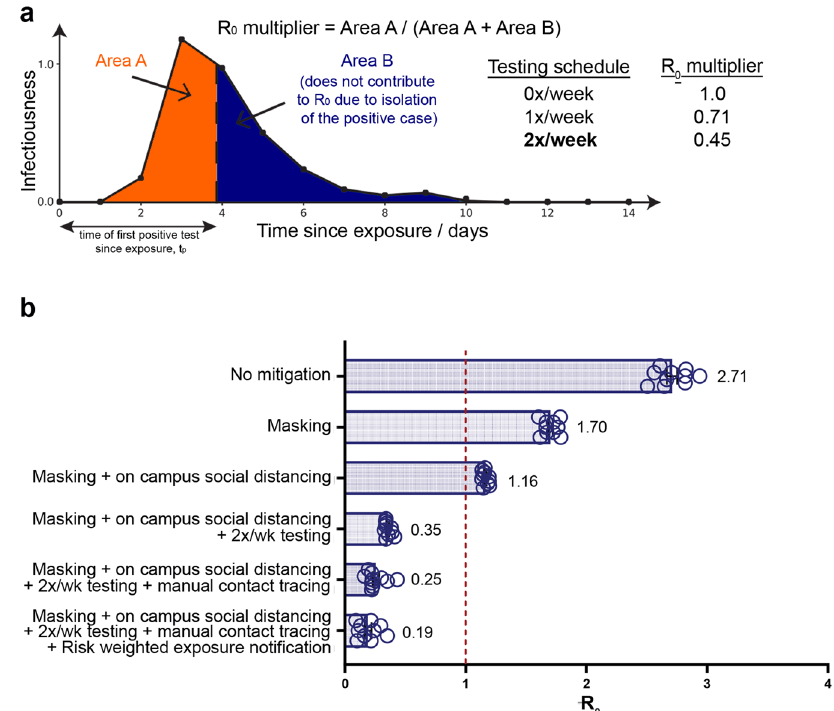
by this index case. Frequent testing and rapid isolation reduce the time period during which a person is infectious but not isolated (Area A). As a result, the R 0 multiplier for testing is the ratio between the truncated area under the curve (Area A) and the untruncated area under the curve (Area A dashed vertical line between Area A and Area B represents the moment an infected individual is isolated; as this line moves to the left, M is decreased